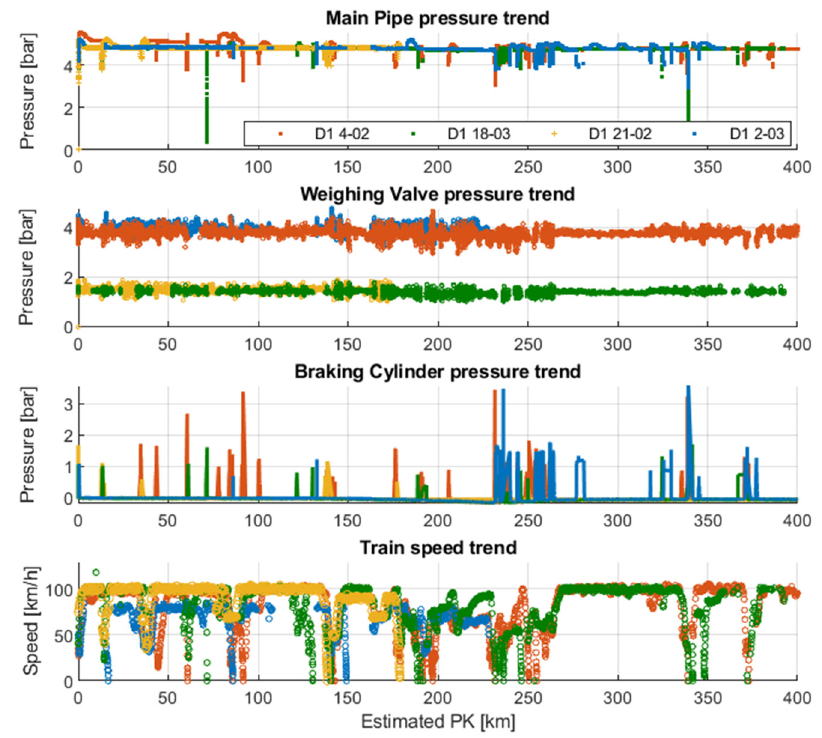
Figure 14. Example of collected pressure data during four different travels (4 February, 21 February, 2 March, 18 March) on the Verona-Rotterdam track.